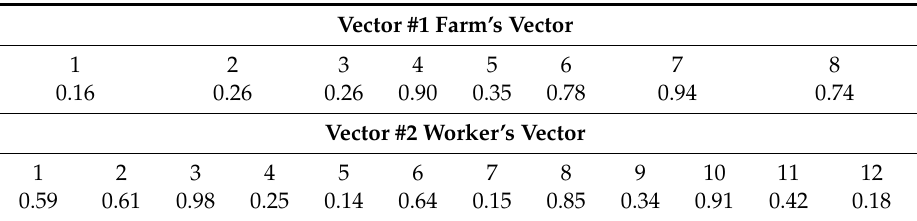
Table 2. Vector values used to generate the initial solution.